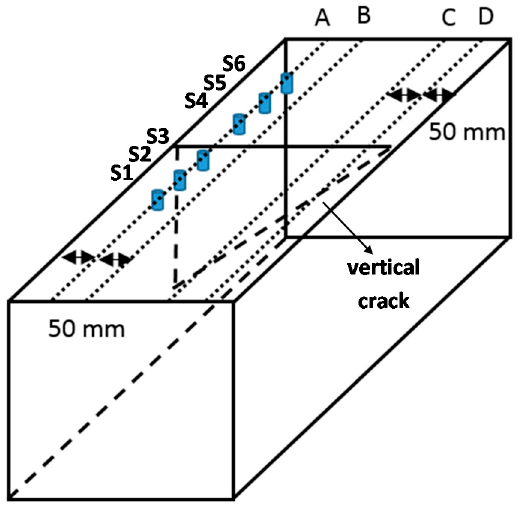
Figure 10. 3D view of concrete specimen block and test grids over surface breaking crack.